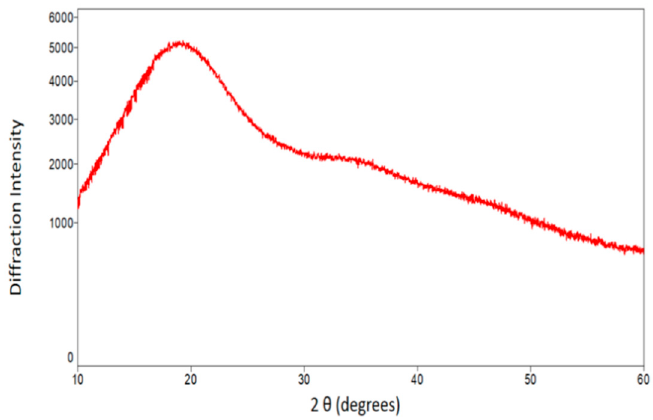
Figure 6. X-ray di ff raction patterns of the Figure 6. X-ray diffraction patterns of the microparticles.